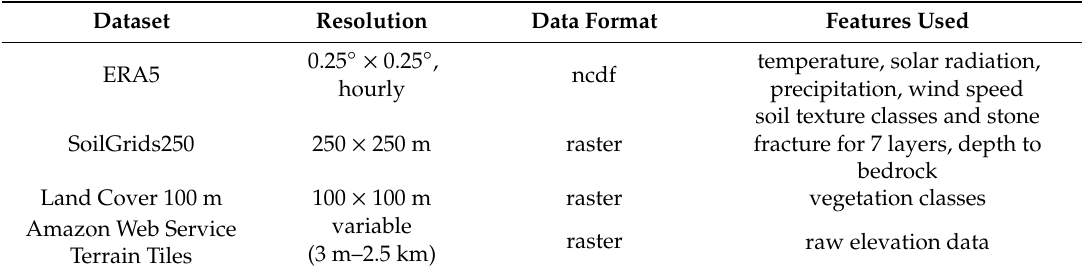
Table 1. Summary of the input